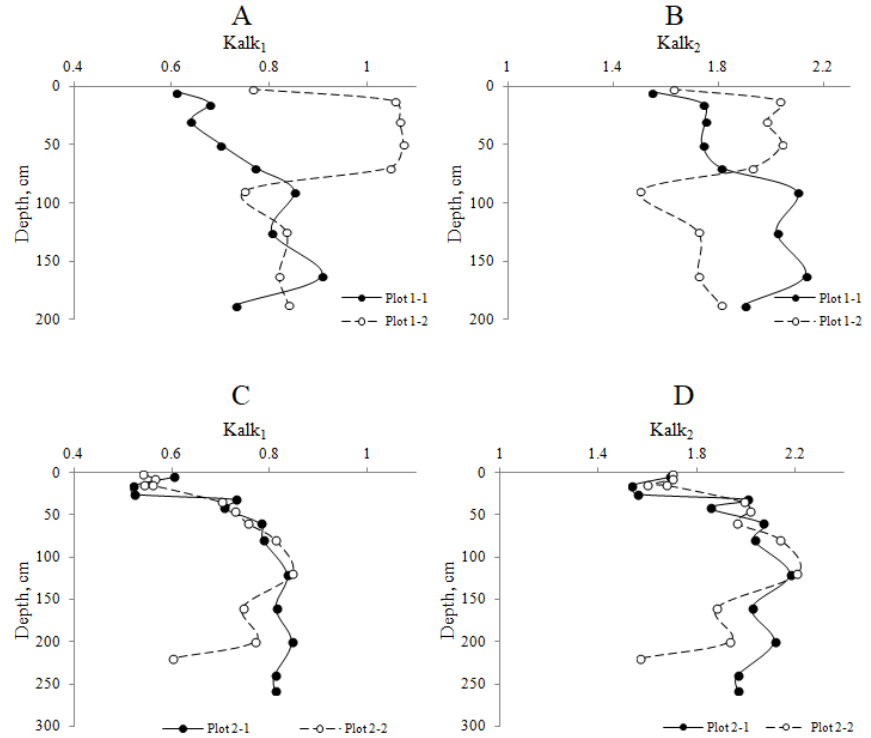
Figure 4. Profile change of the branching index Kalk 1 ( A , C ) and length index Kalk 2 ( B , D ) of HA alkyl chains.